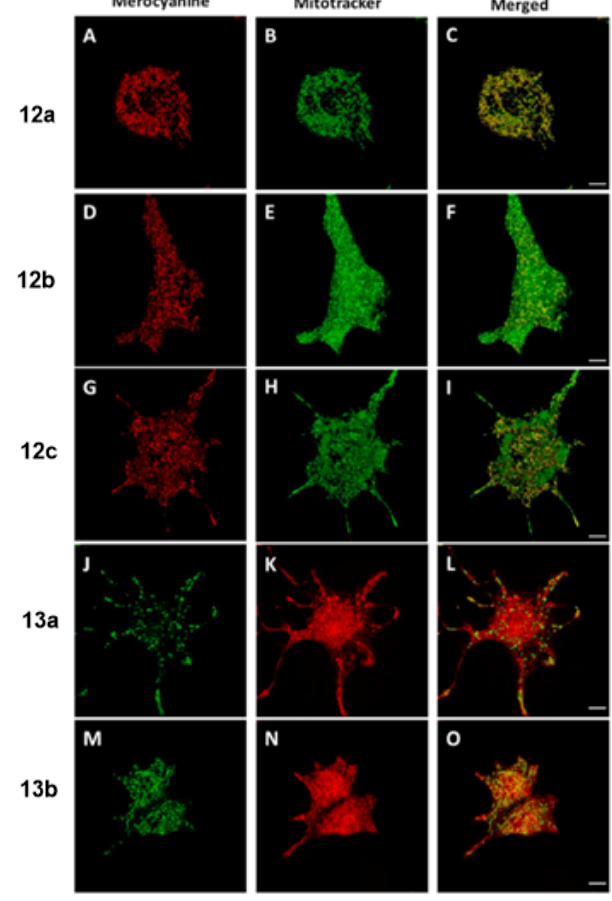
Figure 11. Confocal fluorescence images of PC12 cells stained with merocyanines 1 2a – c , 13a , 13b , MitoTracker™ Red, and MitoTracker™ Green. ( A , D , G , J , M ) Merocyanines 12a – c , 13a , and 13b fluorescence, ( B , E , H ) mitochondria marker MitoTracker™ Green fluorescence, ( K , N ) MitoTracker™ Red fluorescence, ( C , F , I ) merged images of 12a – c with MitoTracker™ Green, and ( L , O ) merged images of 13a or 13b with MitoTracker™ Red. Adapted from [34].